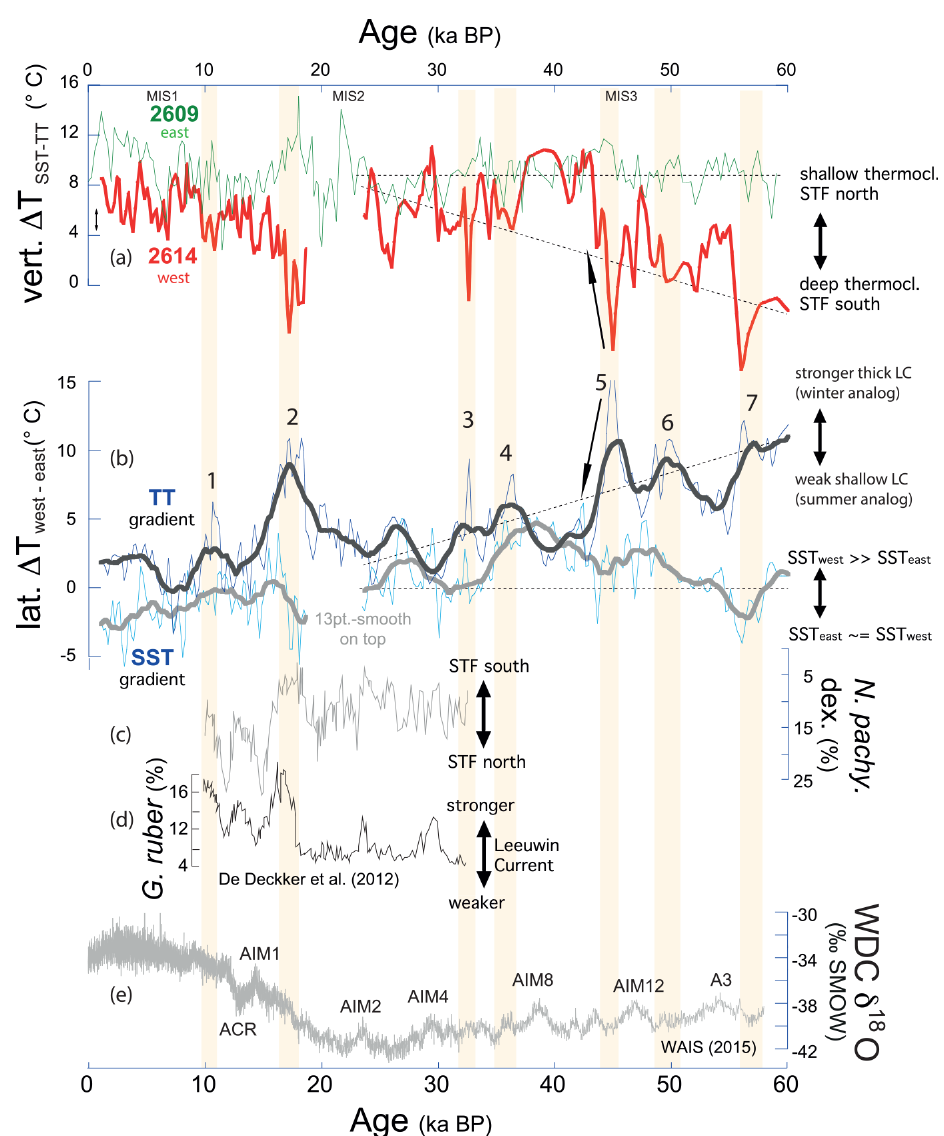
Figure 6. Variability of lateral and vertical temperature gradients south of Australia in comparison to other proxy records over the last 60kyr. (a) Vertical temperature gradients ( (cid:49)T SST-TT ) between sea surface and thermocline reflecting thermocline changes in the western (red) and eastern (green) study areas in line with migrations of the STF. The small double arrow along the y axis marks the modern vertical gradient (30–350m) in the west (Locarnini et al., 2019). (b) Lateral (west–east) 13-point smoothed temperature gradients at the sea surface (grey) and at thermocline depth (black) reflecting Leeuwin Current strength, underlain by the raw data (equally sampled at 0.2kyr spacings using AnalySeries 2.0; Paillard et al., 1996). Stippled lines in (a) and (b) indicate long-term trends. (c) N. pachyderma dextral and (d) G. ruber percentages of core MD03-2611 from De Deckker et al. (2012) reflecting lateral migrations of the STF and changes in Leeuwin Current strength, respectively. (e) West Antarctic Ice Sheet Divide Core δ 18 O record (WAIS Divide Project Members, 2015) as a reference for the Southern Hemisphere climate signal. Orange shading shows short time periods of a strong Leeuwin Current. A3 is the Antarctic warming event. AIM stands for Antarctic Isotope Maxima. MIS stands for Marine Isotope Stages 1–3 (Martinson et al., 1987). ACR stands for Antarctic Cold